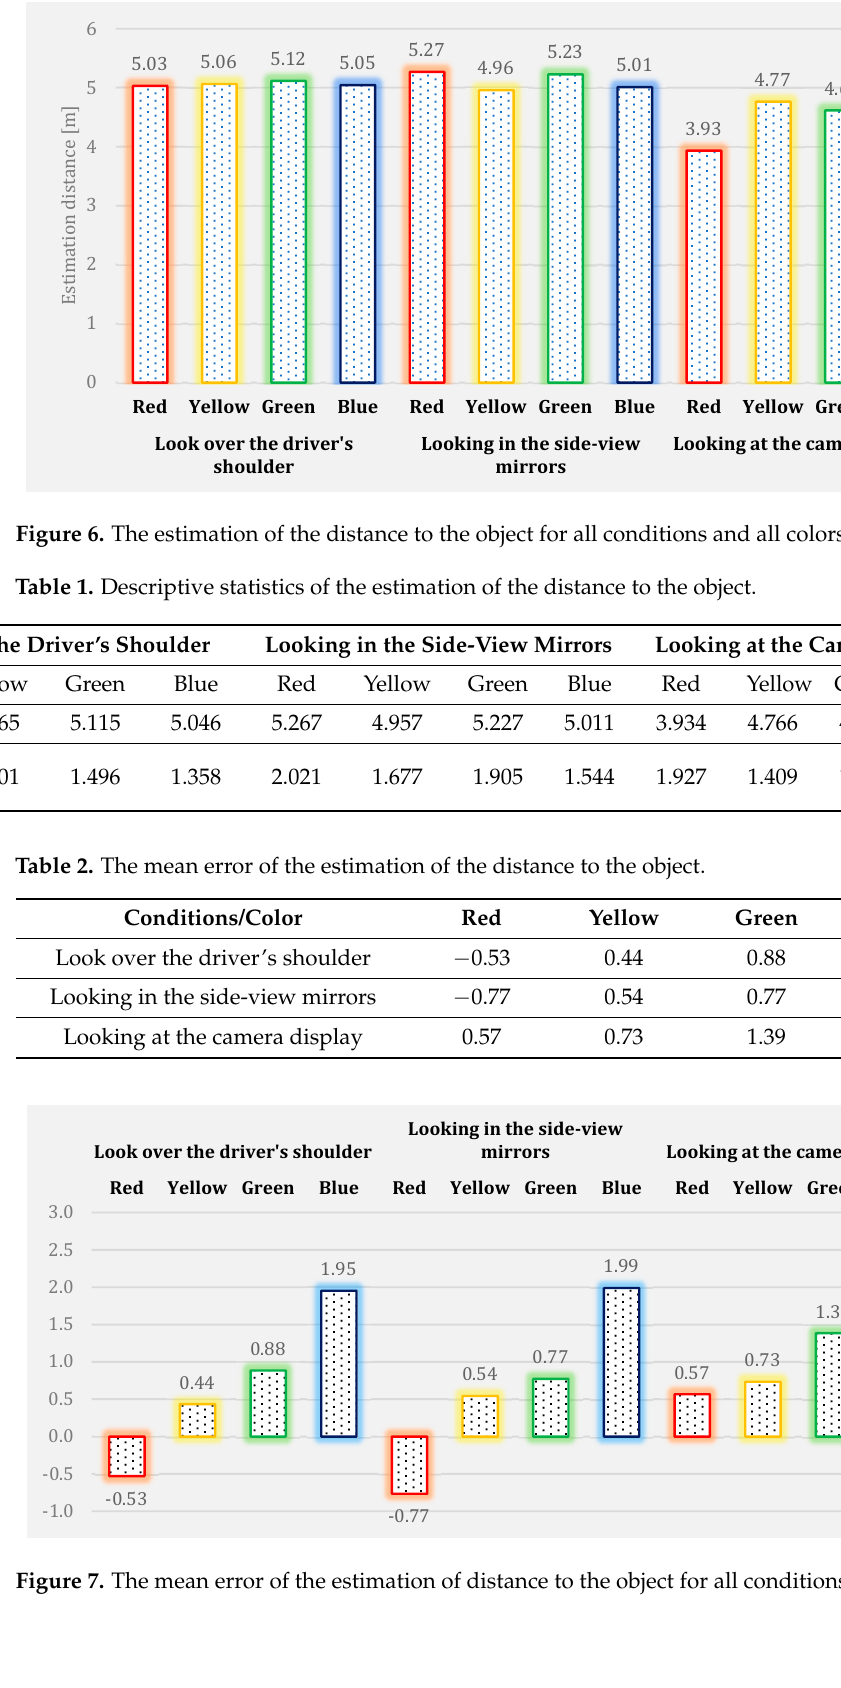
Table 1. Descriptive statistics of the estimation of the distance to the object.